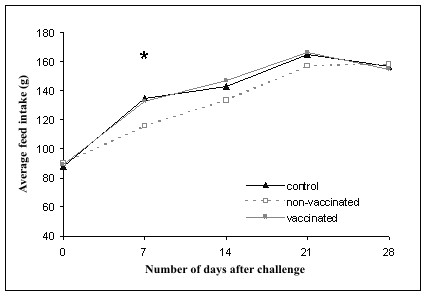
Vaccination experiment followed by challenge with a homologous strain after seven days. Average feed intake of the different groups of rabbits plotted against number of days after challenge. One group was vaccinated with strain 97/246.1Δeae seven days before challenge (day -7; i.e. immediately after weaning), while both the vaccinated and the non-vaccinated group were challenged (day 0) with REPEC 97/223.10 wild-type strain. Significant differences between the non-vaccinated and the other groups are indicated with an asterisk (*:P < 0.05).